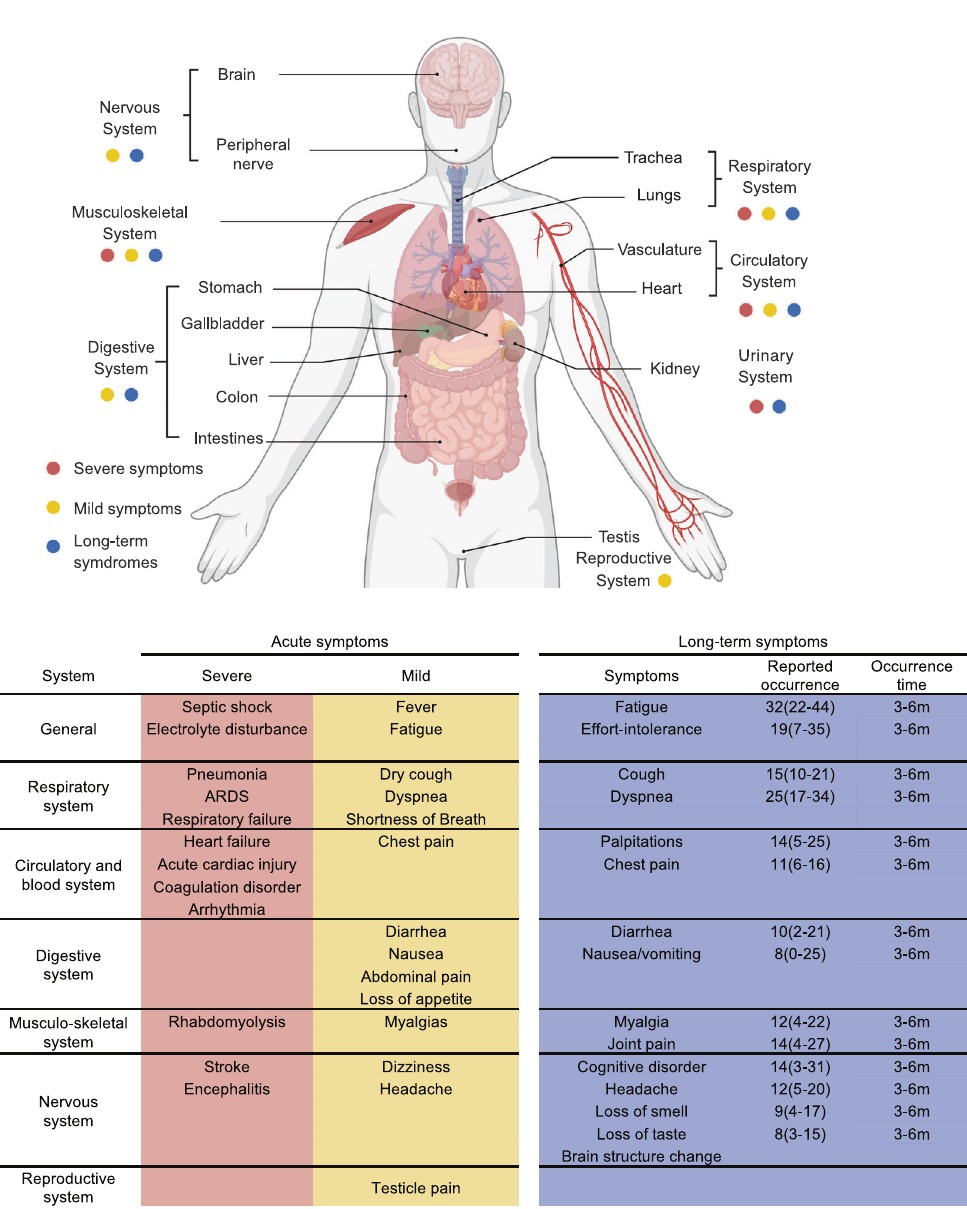
Fig. 12 The overview of SARS-CoV-2 infection affecting the human system and summary of acute and long-term symptoms post. COVID-19 could lead to various symptoms occurring in various body systems except for the expiratory system. The summary table lists the clinical presentations of COVID-19, including severe and mild symptoms during acute infection and long-term symptoms with the occurrence time and rate. The reported occurrence rates of long-term symptoms are average with the 95% con fi dential interval (CI), and the occurrence time is presented as the time (m - month) post-infection. BioRender is used to generate the human body system